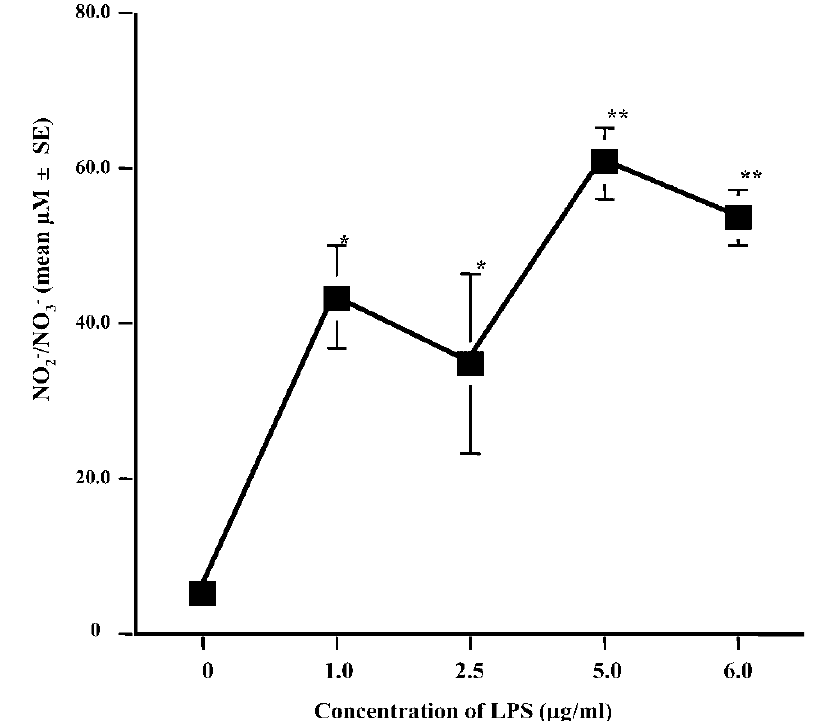
FIG. 2. Dose (cid:1) / response profile of NO (NO 2 (cid:1) /NO 3 (cid:1) ) generation by LPS injection in mice. ICR mice were injected intraperitoneally with various concentrations of LPS, and plasma was obtained 6 h later to assay NO 2 (cid:1) /NO 3 (cid:1) levels. The data are expressed as the mean ( m M) 9 / standard error of five mice. * Significant compared with normal control (0 m g/kg); ** significant compared with 2.5 mg/kg of LPS.